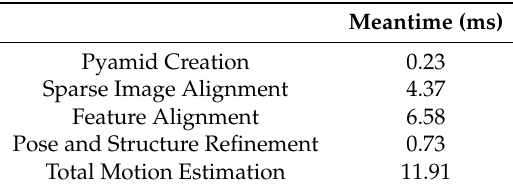
Table 5. The algorithm in this